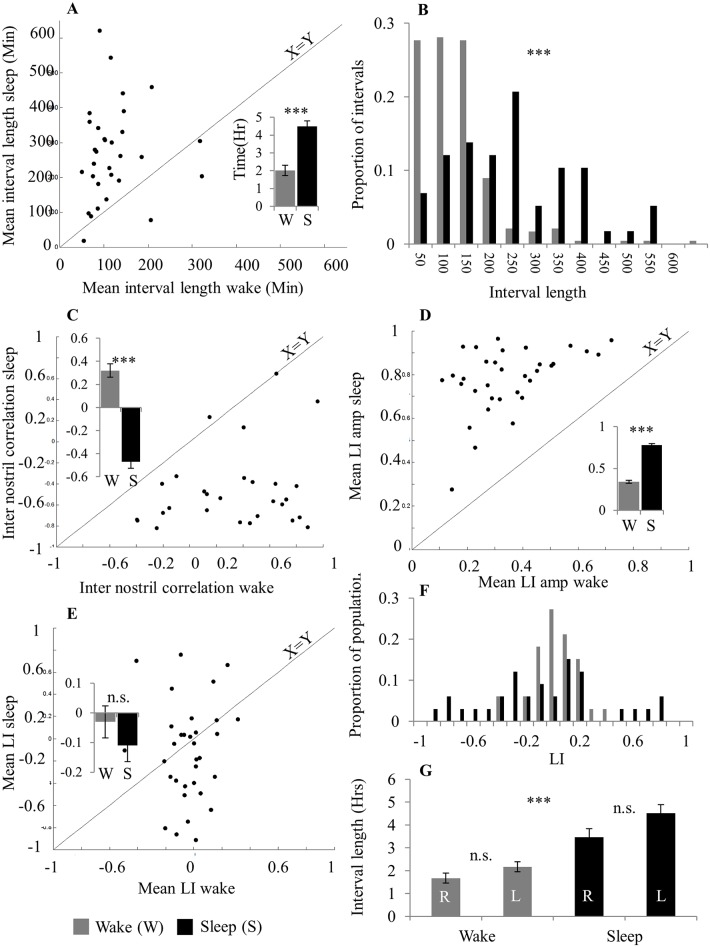
The nasal cycle differed in wake and sleep.(A) Mean interval length. Inset: Mean over population. (B) Distribution of wake and sleep interval lengths across subjects. (C) Inter nostril correlation. Inset: Mean over population. (D) Mean LI amplitude Inset: Mean over population. (E) Mean LI. Inset: Mean over population. (F) Distribution of wake and sleep mean LI across subjects. (G) Right and left interval means during wake and sleep. In scatter plots each dot is a subject and the diagonal line is the unit slope line (X = Y). Error bars are SE.